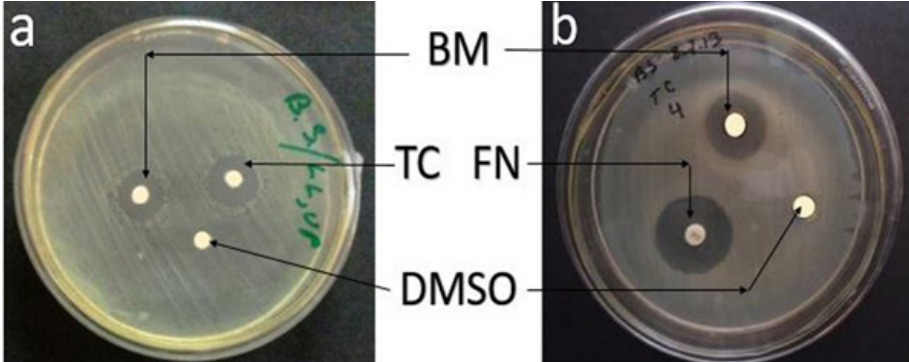
Fig. 1. Antimicrobial activity of bioactive metabolite (BM) produced by G. pallida (KU693285) against (a) Bacillus subtilis and (b) Candida albicans (MTCC183), Positive Control-(a) Tetracycline (TC-30 µg/dsc) and (b), Fluconazole (FN-10 µg/disc), Negative Control-Dimethyl sulfoxide (DMSO)